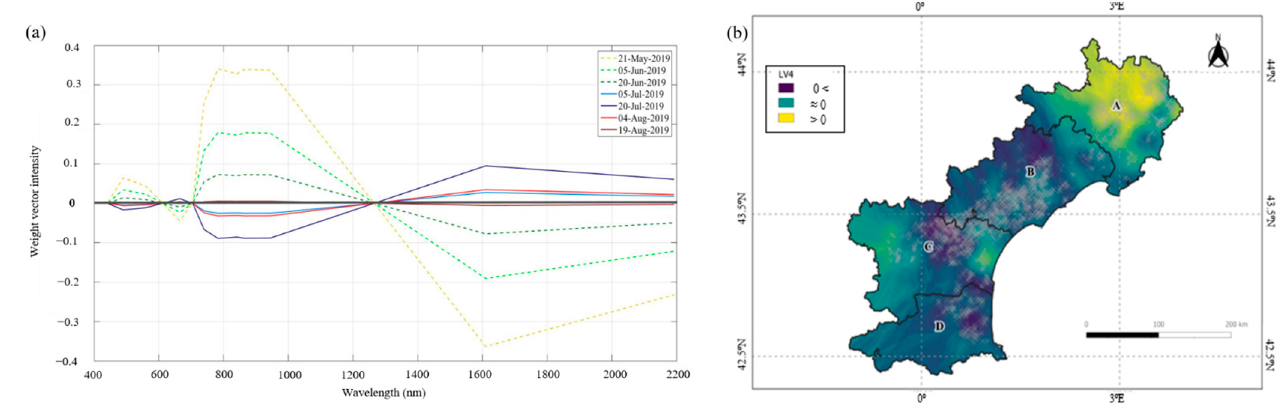
Figure 11. ( a ) LV4 weight vectors from N-PLS applied to the calibration set (75% of the 107 vineyard blocks) for each date; ( b ) kriged map of the LV4 score values for blocks at the regional scale. The most negative score values of the blocks on LV4 ( b ) are shown in blue, and the most positive score values in yellow.